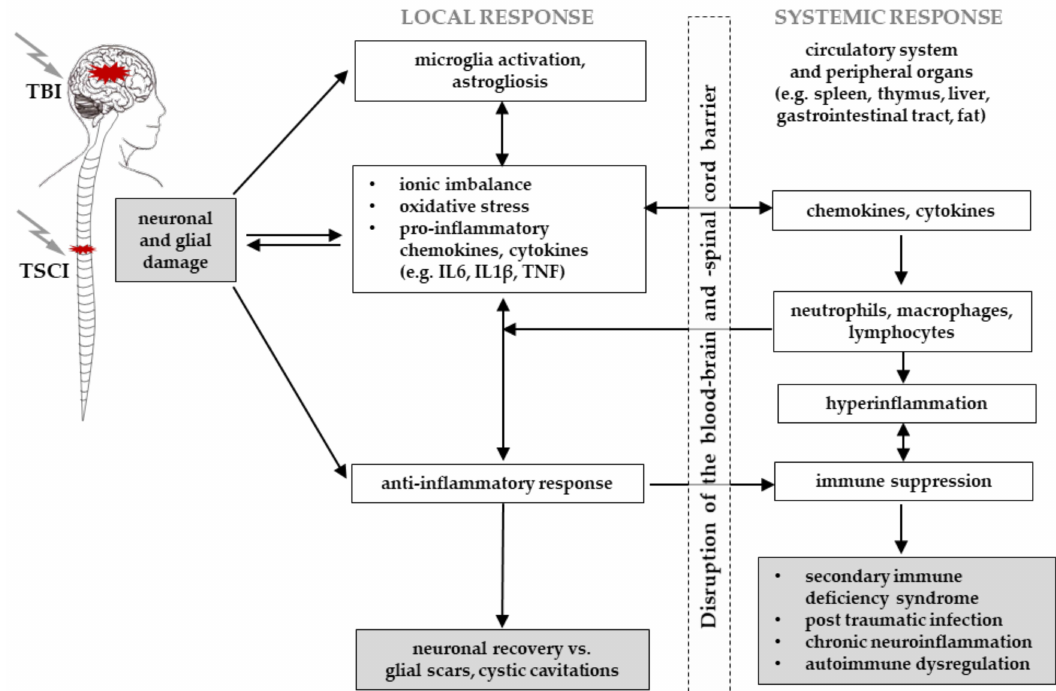
Figure 4. Proposed local and systemic immune response following injury to the central nervous system: TSCI and TBI. The initial primary injury causes neuronal and glial as well as meningeal and vascular damage, which activates the local innate immunity. In response, the level of pro- and anti-inflammatory molecules increases, which triggers peripheral immune cells to access the injury site through the disrupted blood–brain and blood–spinal cord barriers, resulting in a systemic immune response. While the balance of pro- and anti-inflammatory mediators induces repair processes aiming for neuronal recovery, potentially leaving glial scars and cystic cavitations, a dysfunctional response can result in systemic hyperinflammation with damage to peripheral organs and sepsis, chronic neuroinflammation, and autoimmunity, as well as systemic immune suppression and secondary immune deficiency syndrome. Graphic inspired by [123]. Abbreviations: IL =